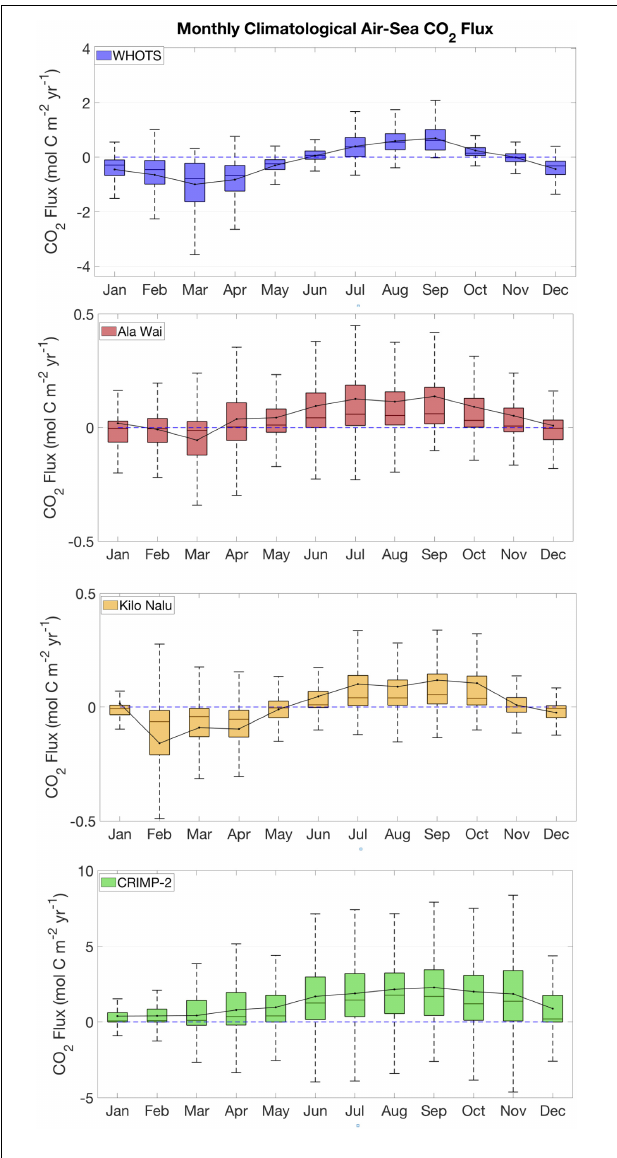
FIGURE 6 | Monthly climatological box plots of air-sea CO 2 fluxes, based on data from June 2008 through December 2016, at all sites. The blue dashed line illustrates a flux of zero, positive values indicates that the area is a source of CO 2 to the atmosphere. See Figure 5 for plot